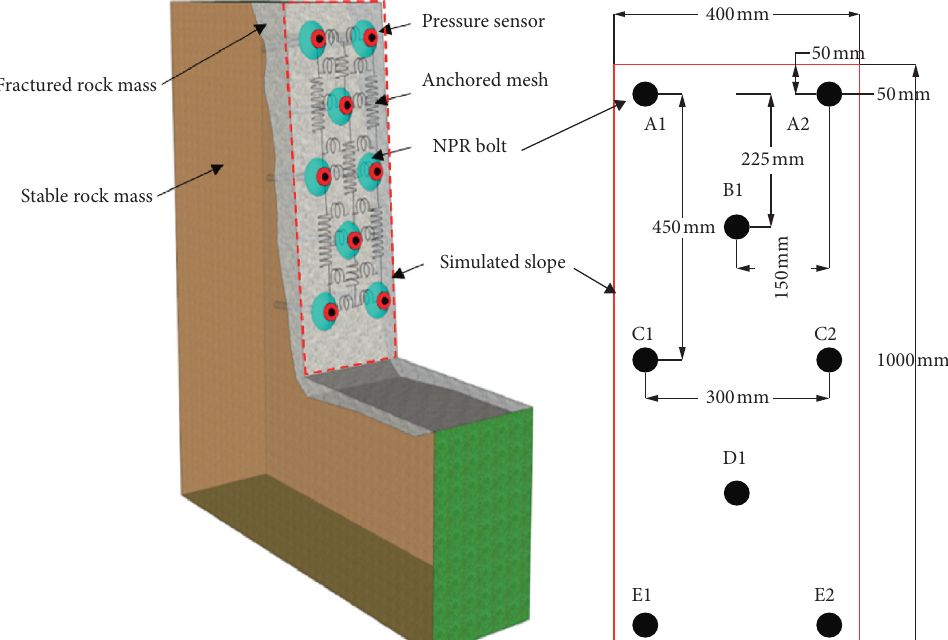
Figure 11: NPR bolt support system